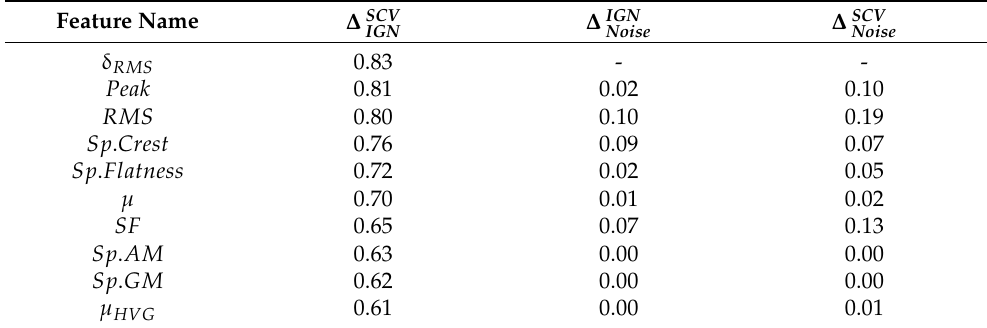
Table 1. Performance analysis of selected